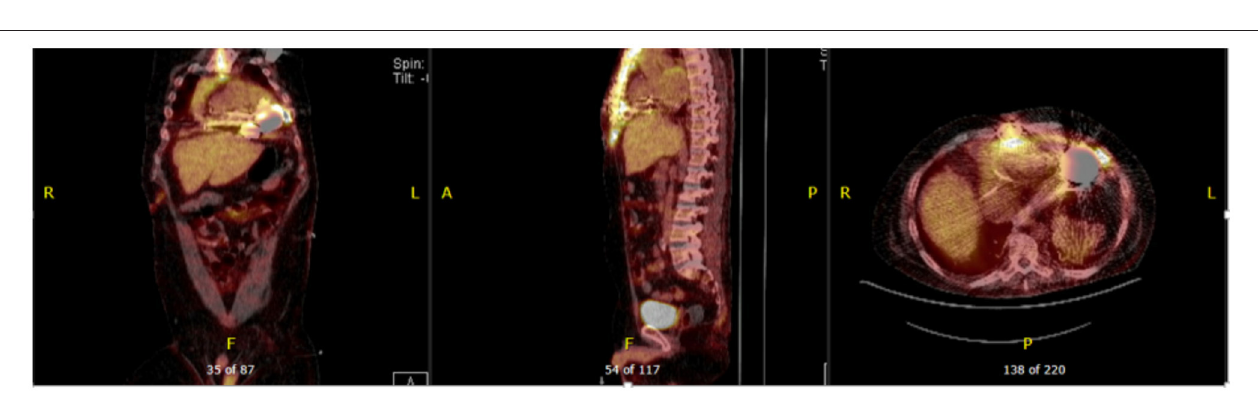
FIGURE 6 | Forty seven year-old male with ischemic cardiomyopathy s/p LVAD (Heart Mate 3) presented with suspected DLI, with wound cultures positive for Candida Albicans. 18 F-FDG PET-CT showed FDG activity in the pericardium, mediastinum, surrounding LVAD pump, driveline and sternum consistent with deep and superficial LVAD infection. He was managed with systemic lifelong antifungal